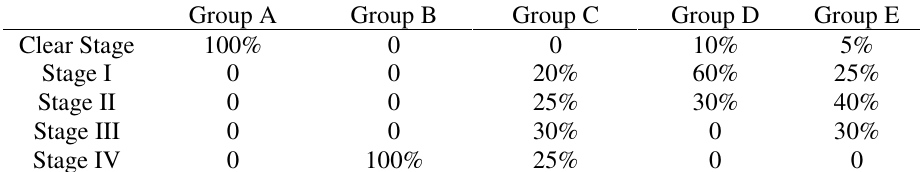
Table 4. Effect of Triphala ghrita on the onset of galactose- induced cataract in rats observed after 30